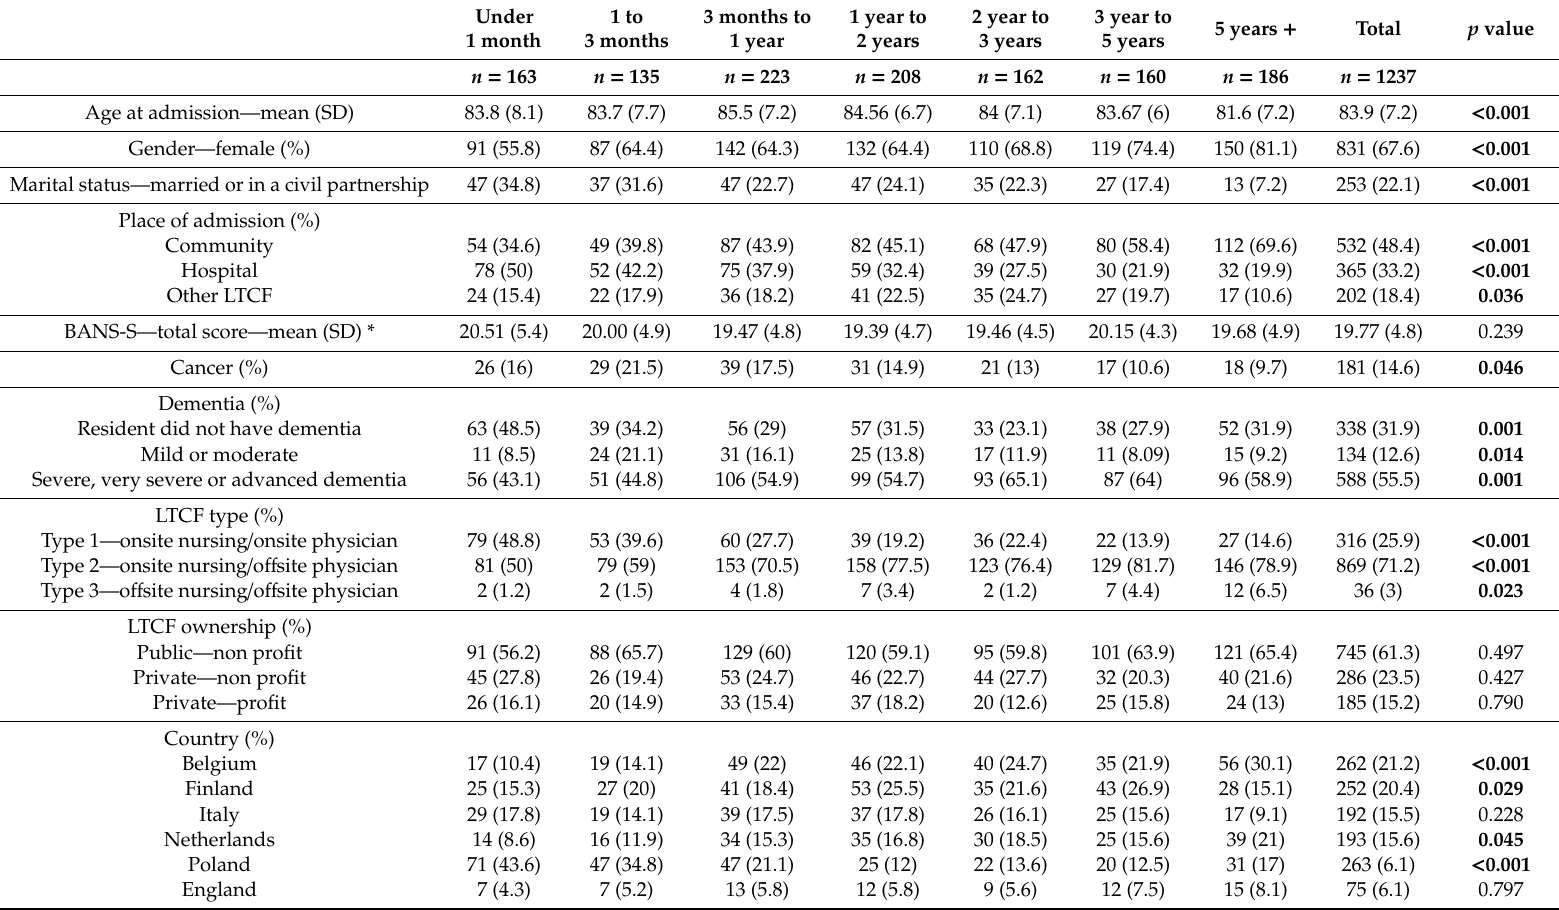
Table 1. Characteristics of deceased long term care facility (LTCF) residents by length of stay in a LTCF until